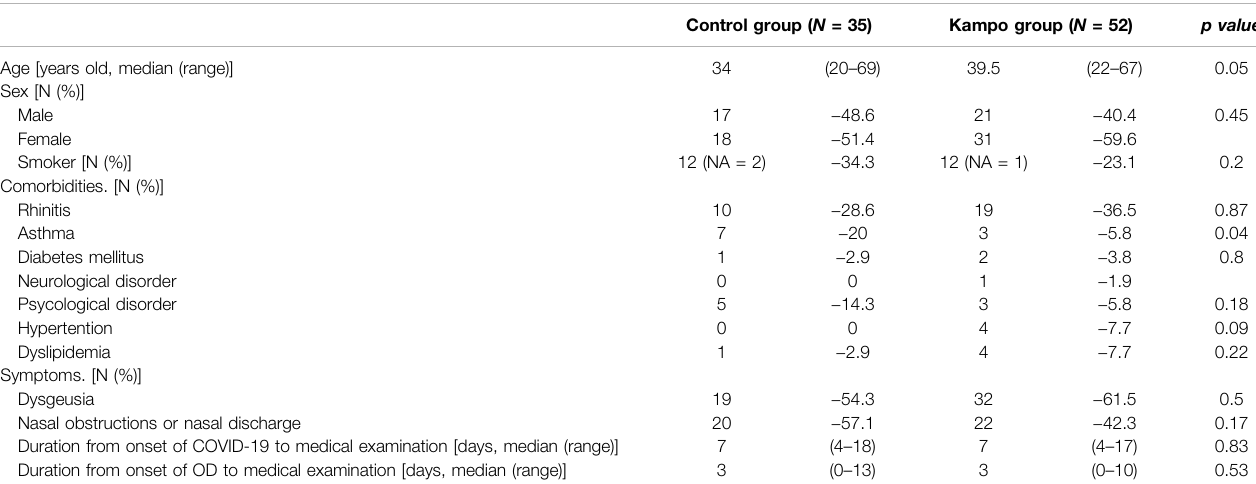
TABLE 1 | Characteristics of study